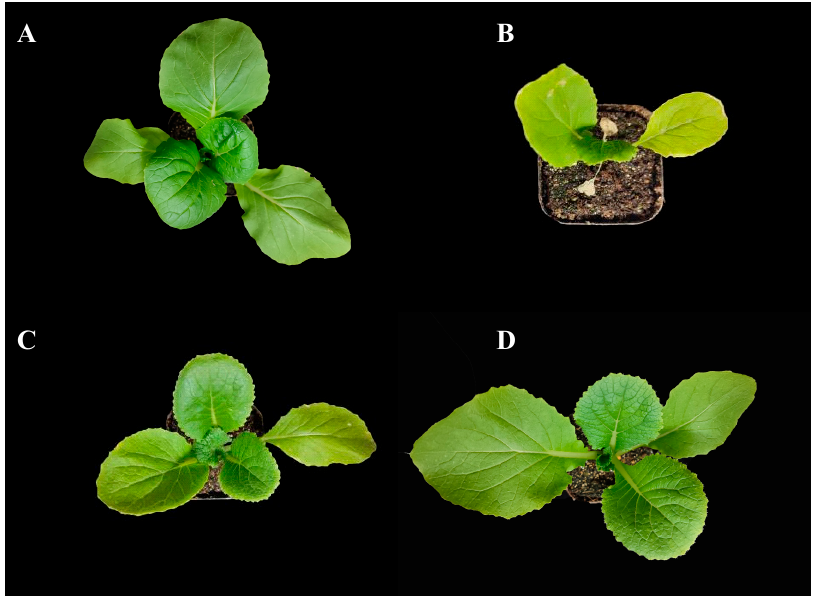
Figure 1. Morphology and growth phenotypes in response to exogenous GB and BABA in B. rapa under heat stress. Ctrl ( A ), optimum conditions; HT + Ctrl ( B ), HT + GB ( C ), and HT + BABA ( D ) seedlings were foliar sprayed with water, GB, and BABA, respectively, before exposure to high temperature. Table 1. Effects of GB and BABA on plant growth of Chinese cabbage under heat stress.